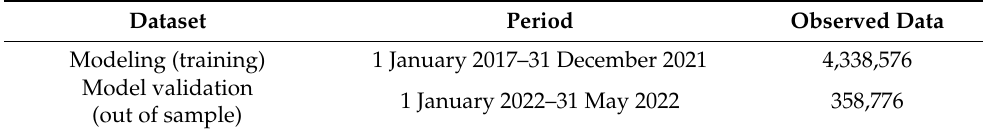
Table 2. Composition of the